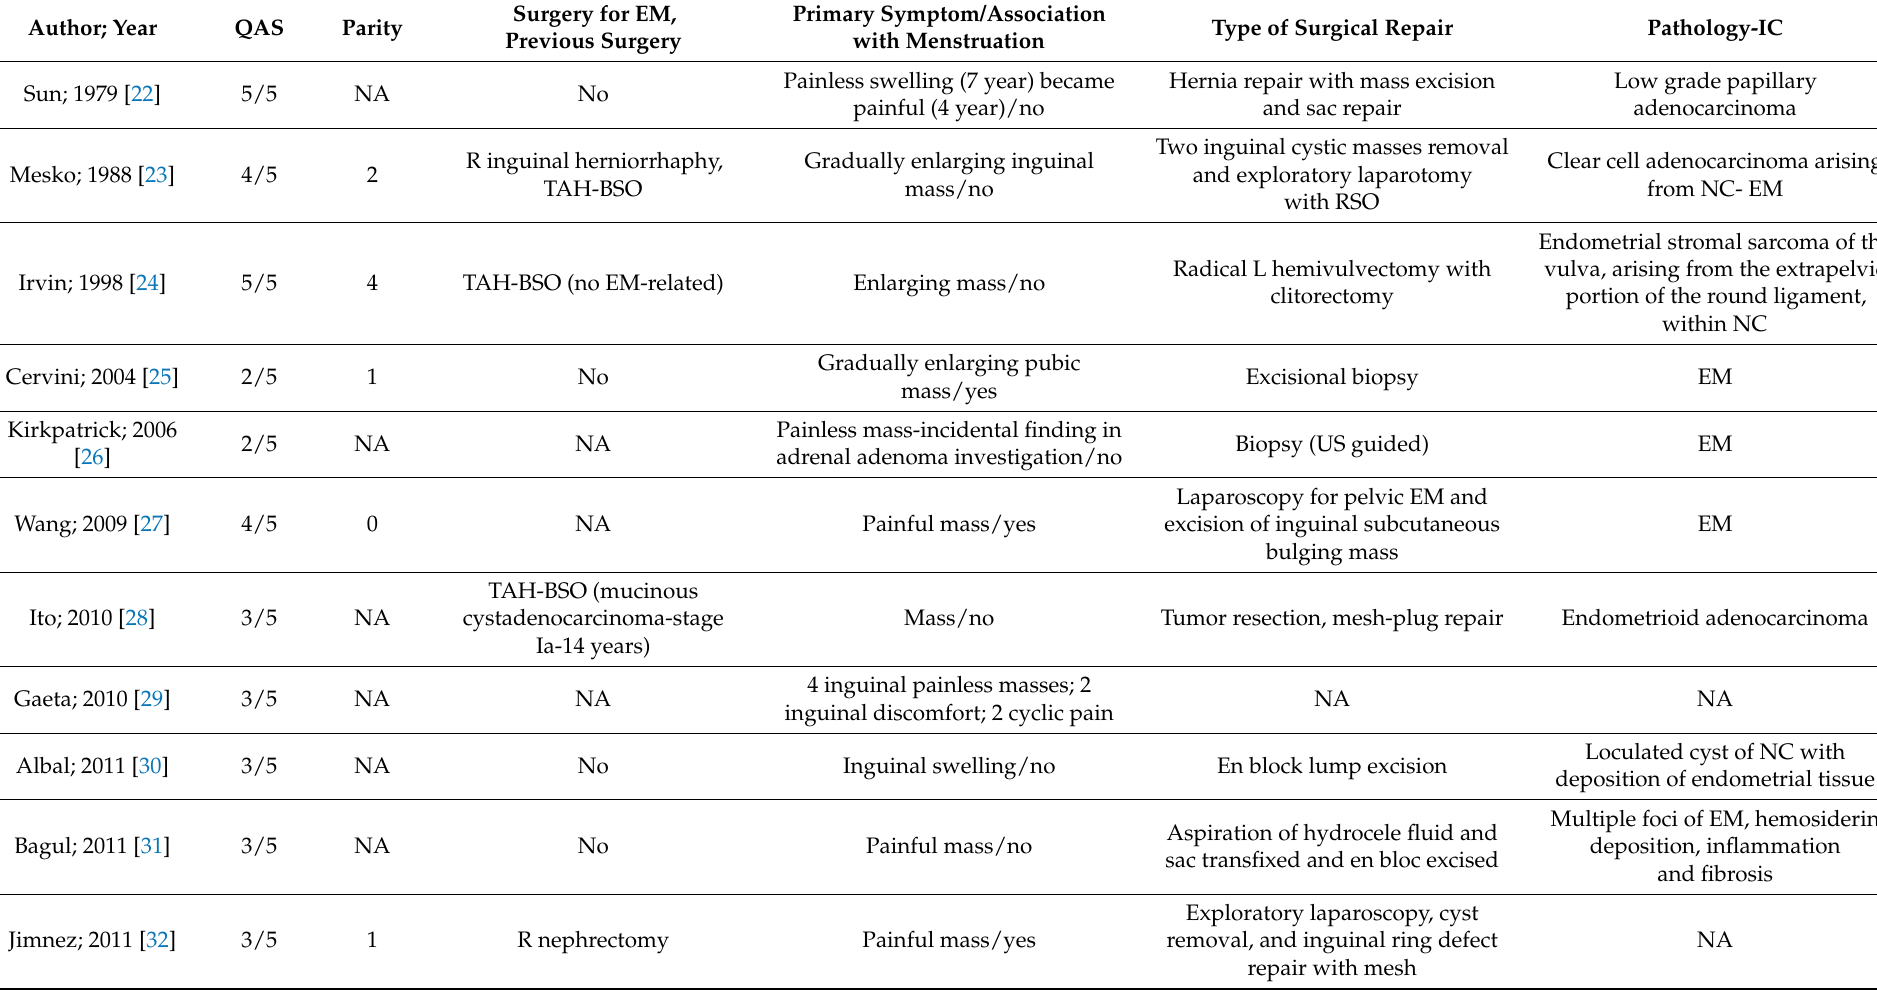
Table 1. Pre-, intra-, and postoperative characteristics of the included